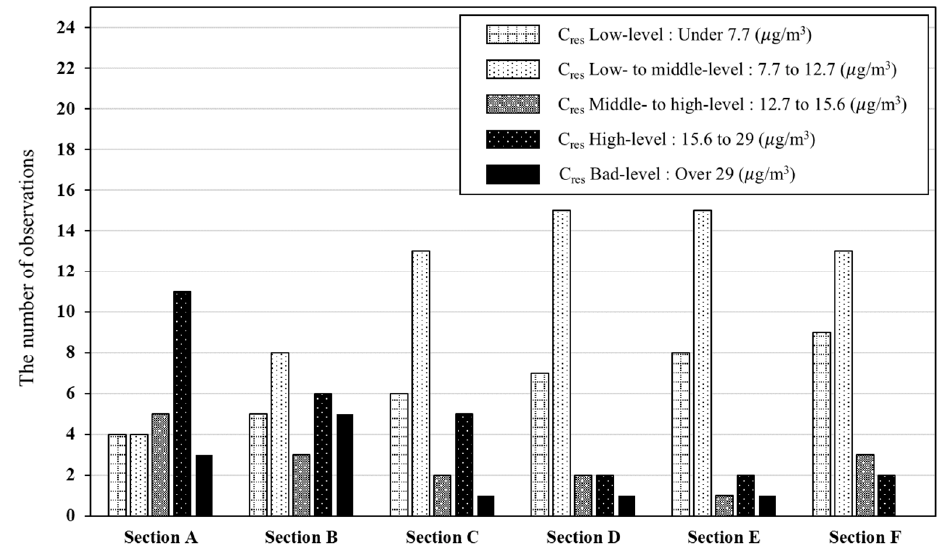
Figure 9. Comparison of the number of C res level type observations. Table 4. Comparison of observed C res bad level concentrations by section and Bg concentration of the same time zone.